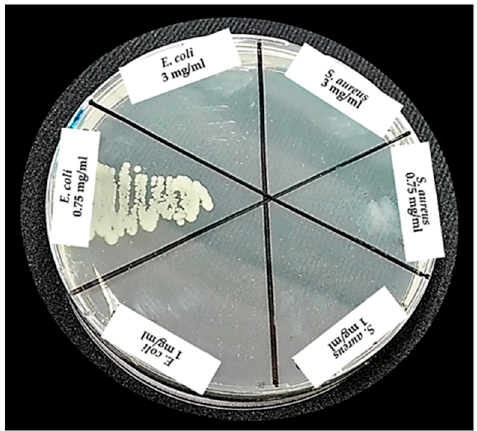
Figure 10. Sowing from the tubes with strains of E. coli and S. aureus at concentrations of 3, 0.75, and 1 mg/mL of nZH-Cu.